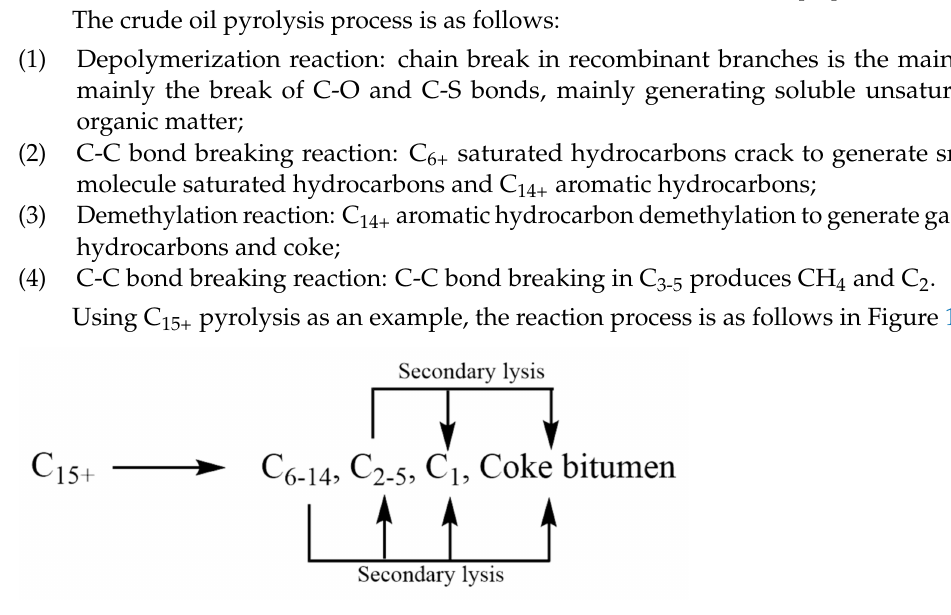
Figure 1. C 15+ pyrolysis reaction process